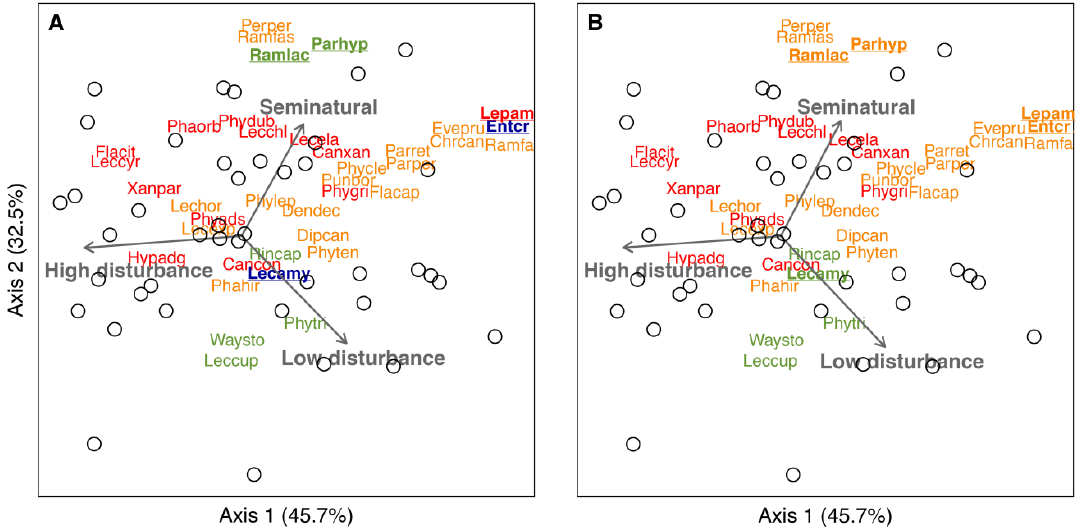
Figure 2. Nonmetric multidimensional scaling (NMS) ordination plot of Lisbon urban green spaces (hollow circles; n = 41) according to lichen species composition with overlaying vectors representing the community weighted mean (CWM) of the functional groups belonging to the poleotolerance trait. ( A ) Shows species colored with the original classification (misclassified species underlined) and the corresponding CWM vectors. ( B ) Shows species colored after classification correction (reclassified species underlined) and the CWM functional group vectors recalculated after this correction. Each color represents one of the lichen functional groups (high disturbance—red; low disturbance—orange; seminatural—green; natural—blue). The first two axes explain, respectively, 45.7% and 32.5% of the variance. Only significant variables are shown to prevent overcrowding. See species code names in Annex I.